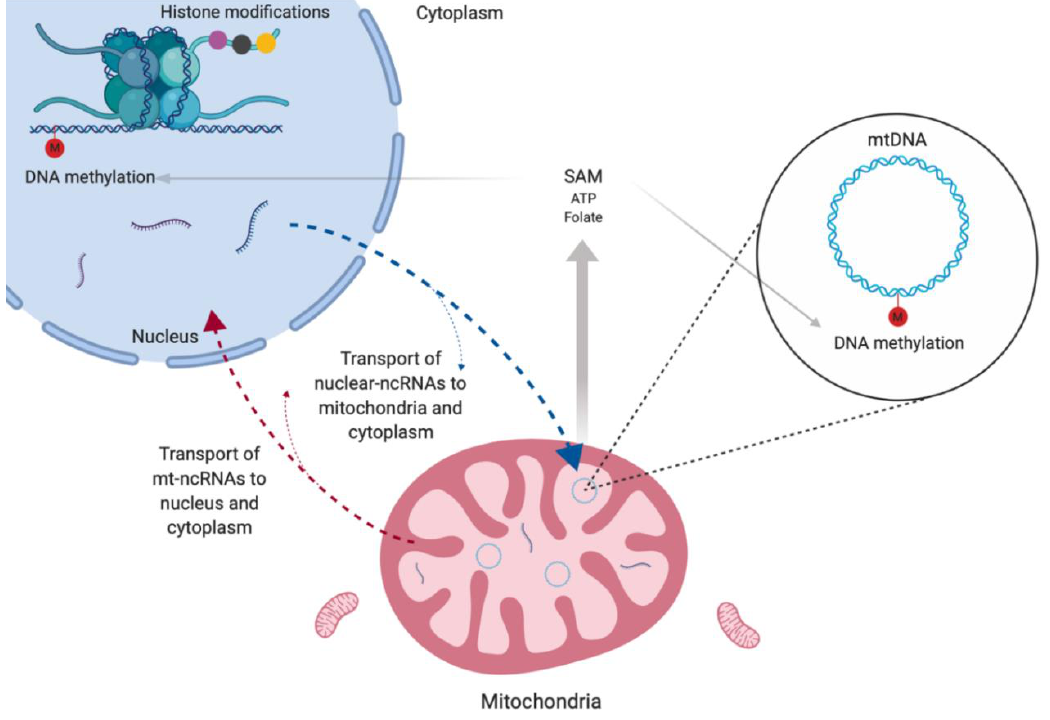
Figure 2. Mitochondrial epigenetics. Scheme showing the occurrence of DNA methylation in mtDNA and of non-coding RNAs (ncRNAs) inside mitochondria. These ncRNAs are encoded by both nucleus and mitochondrial genomes and participate of the nuclei–mitochondria communication. Mitochondrial metabolism is responsible for the production of the universal methyl donor (SAM), which is used in all DNA methylation events in a cell.